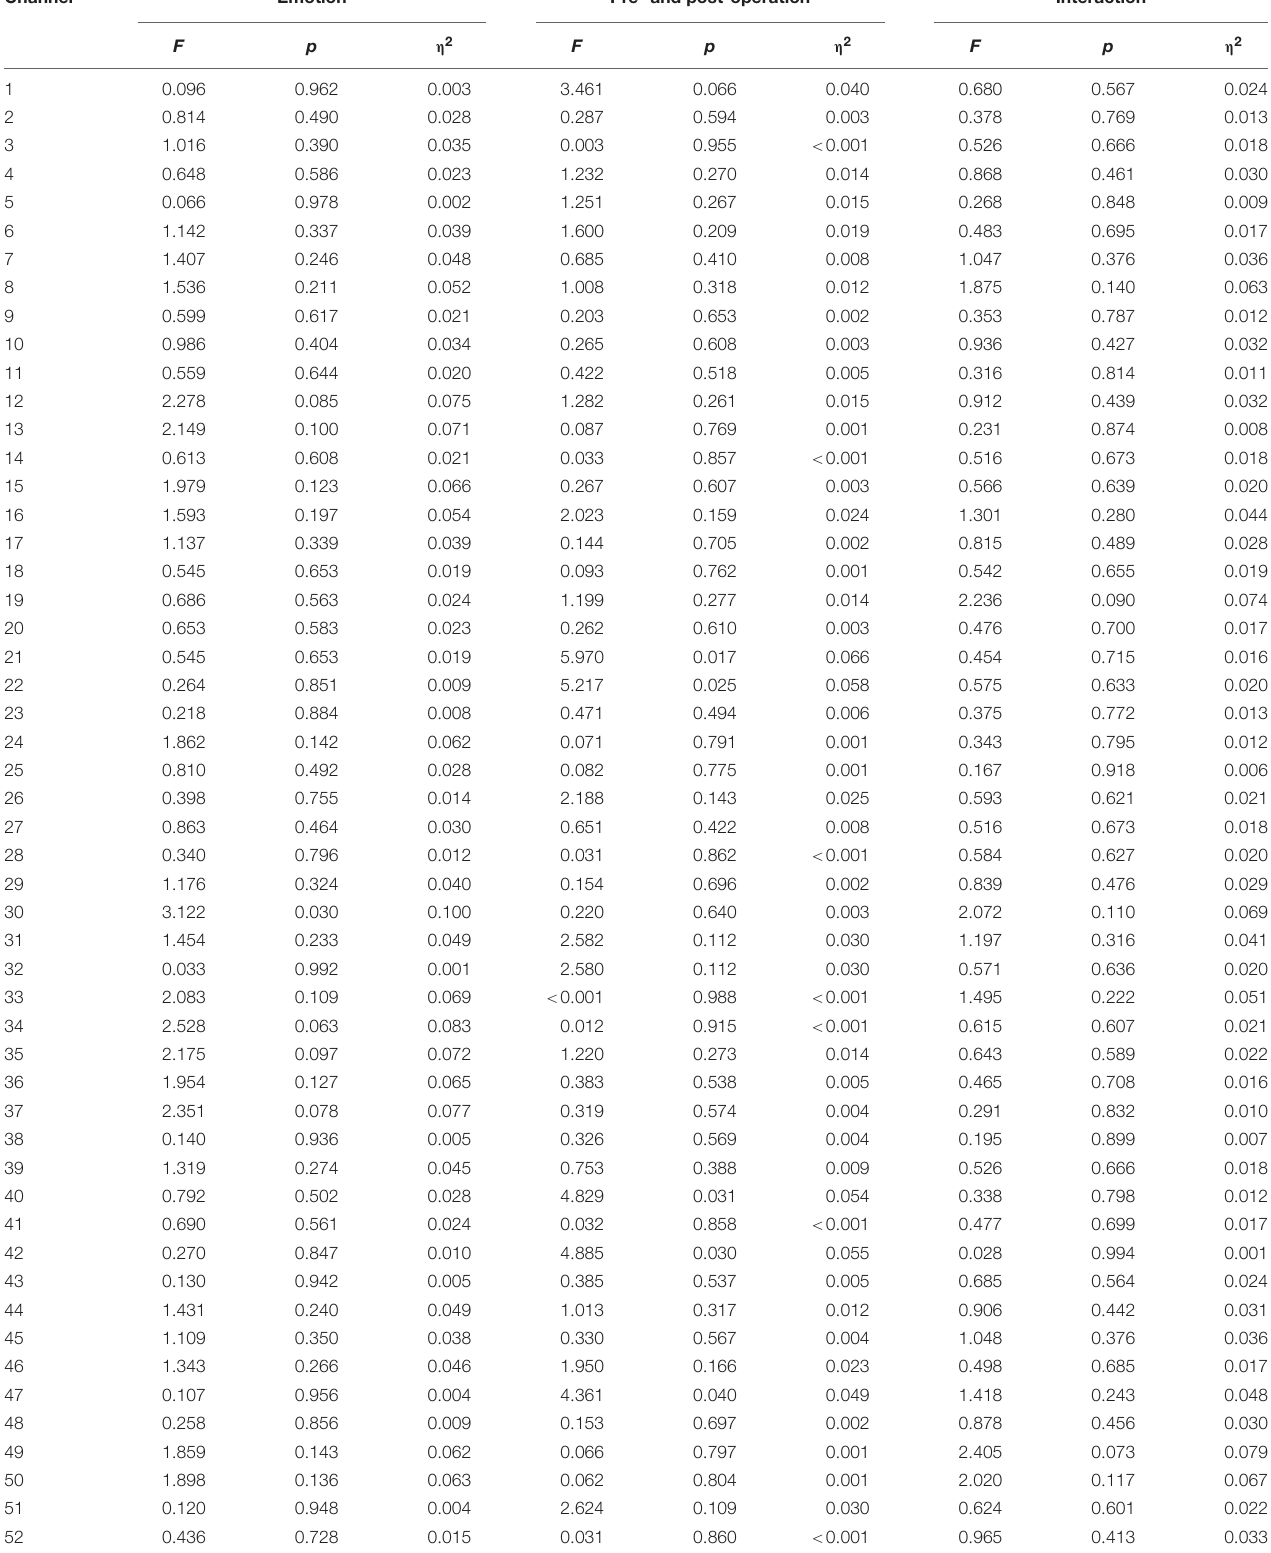
TABLE 3 | Statistical results of fNIRS